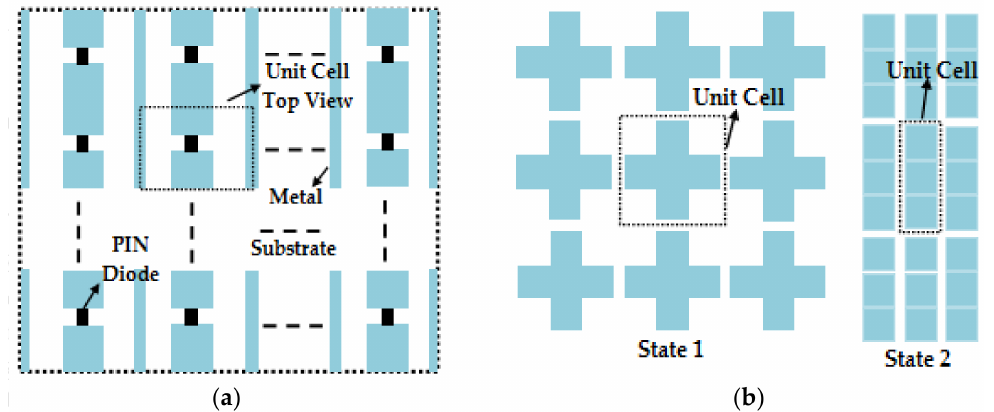
Figure 18. ( a ) Top-view of AFSS with unit cell display. ( b ) Reconfigurable all-dielectric FSS with two states (1 and 2) and unit